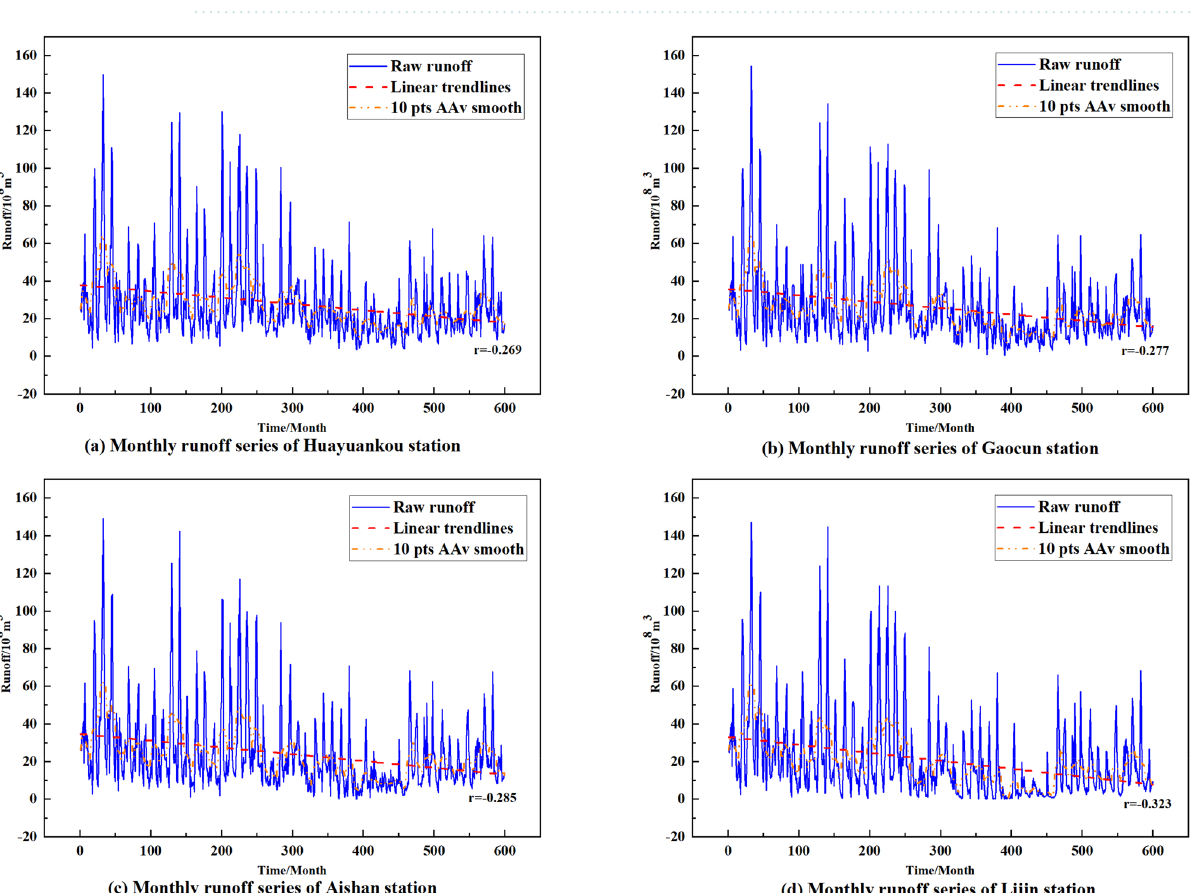
Figure 4. The course of monthly runoff at each hydrological station